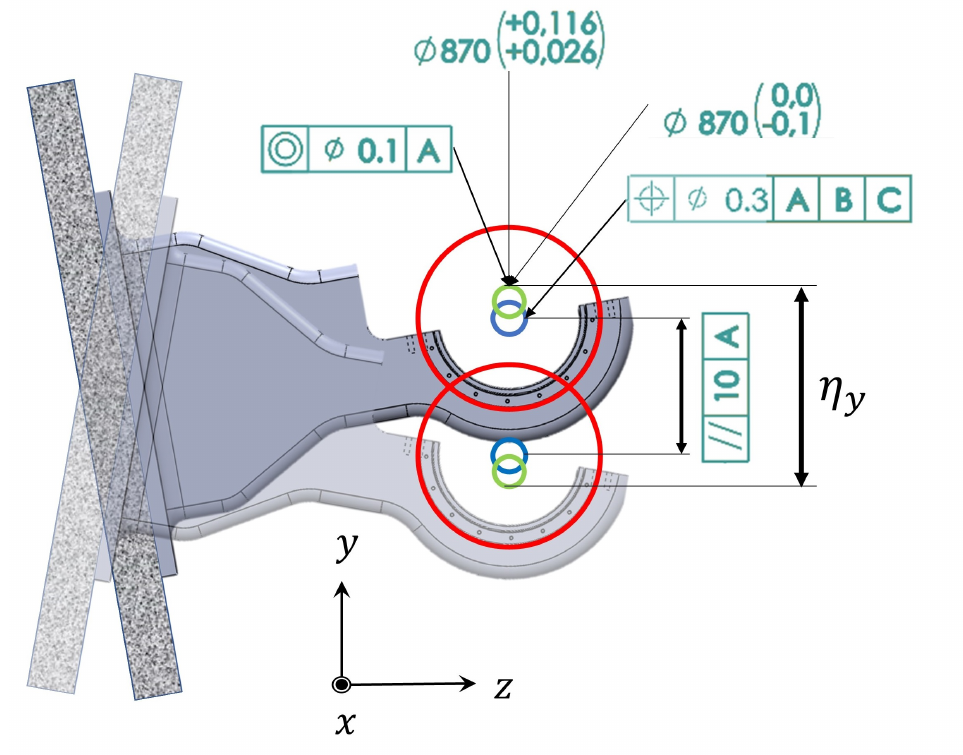
Figure 7. Vertical deviations: scheme of the effect of tolerances on the position of the centers of the